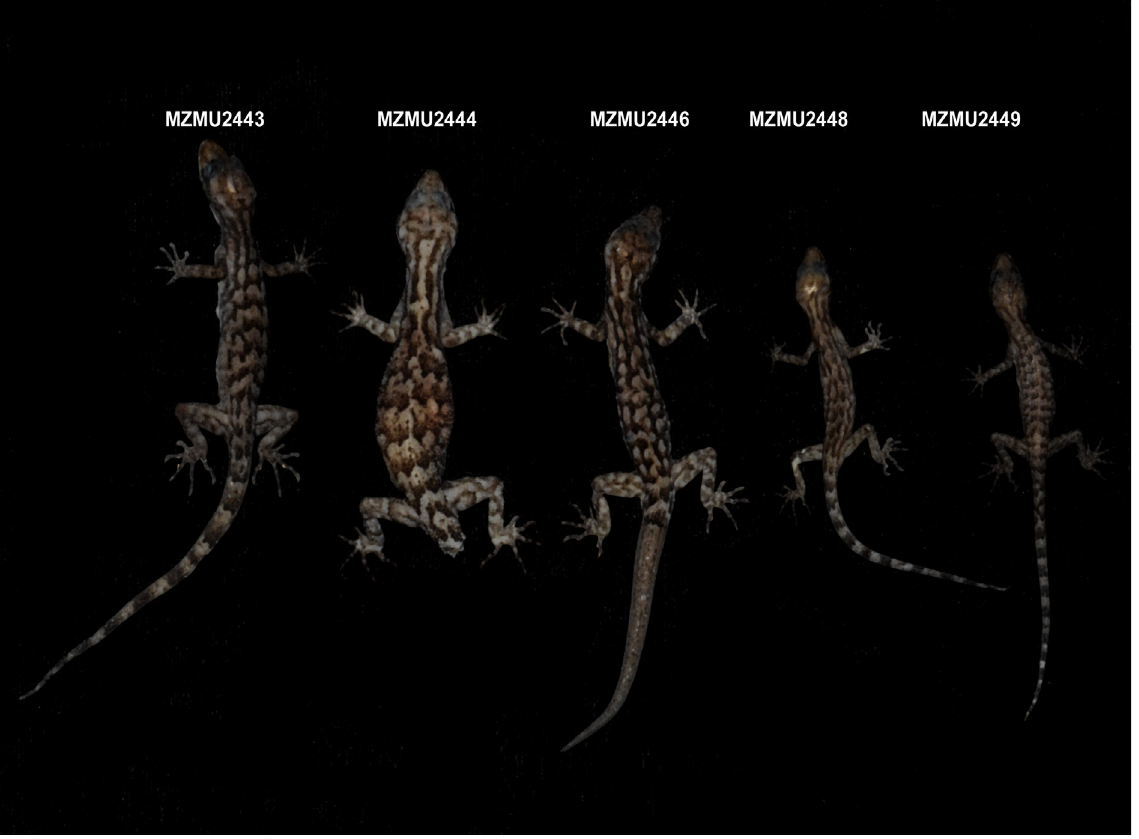
Fig. 9. Type series of Cyrtodactylus siahaensis sp.